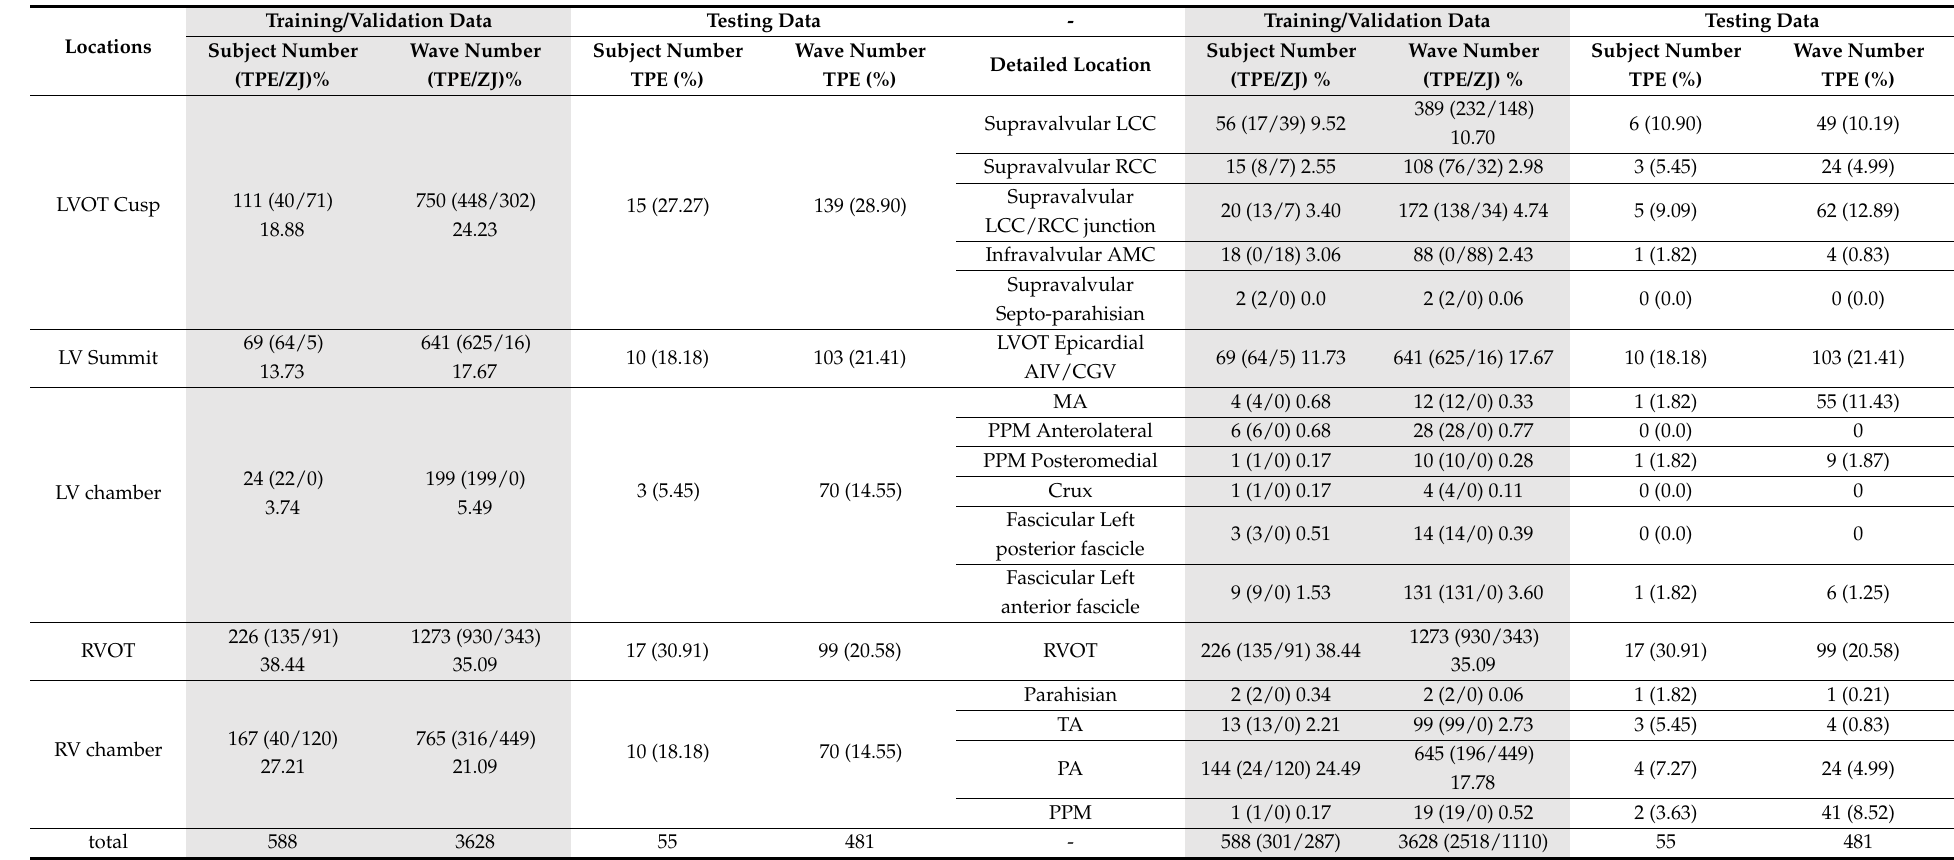
Table 1. Composition of Ventricular Premature Contraction source of training/validation data and testing